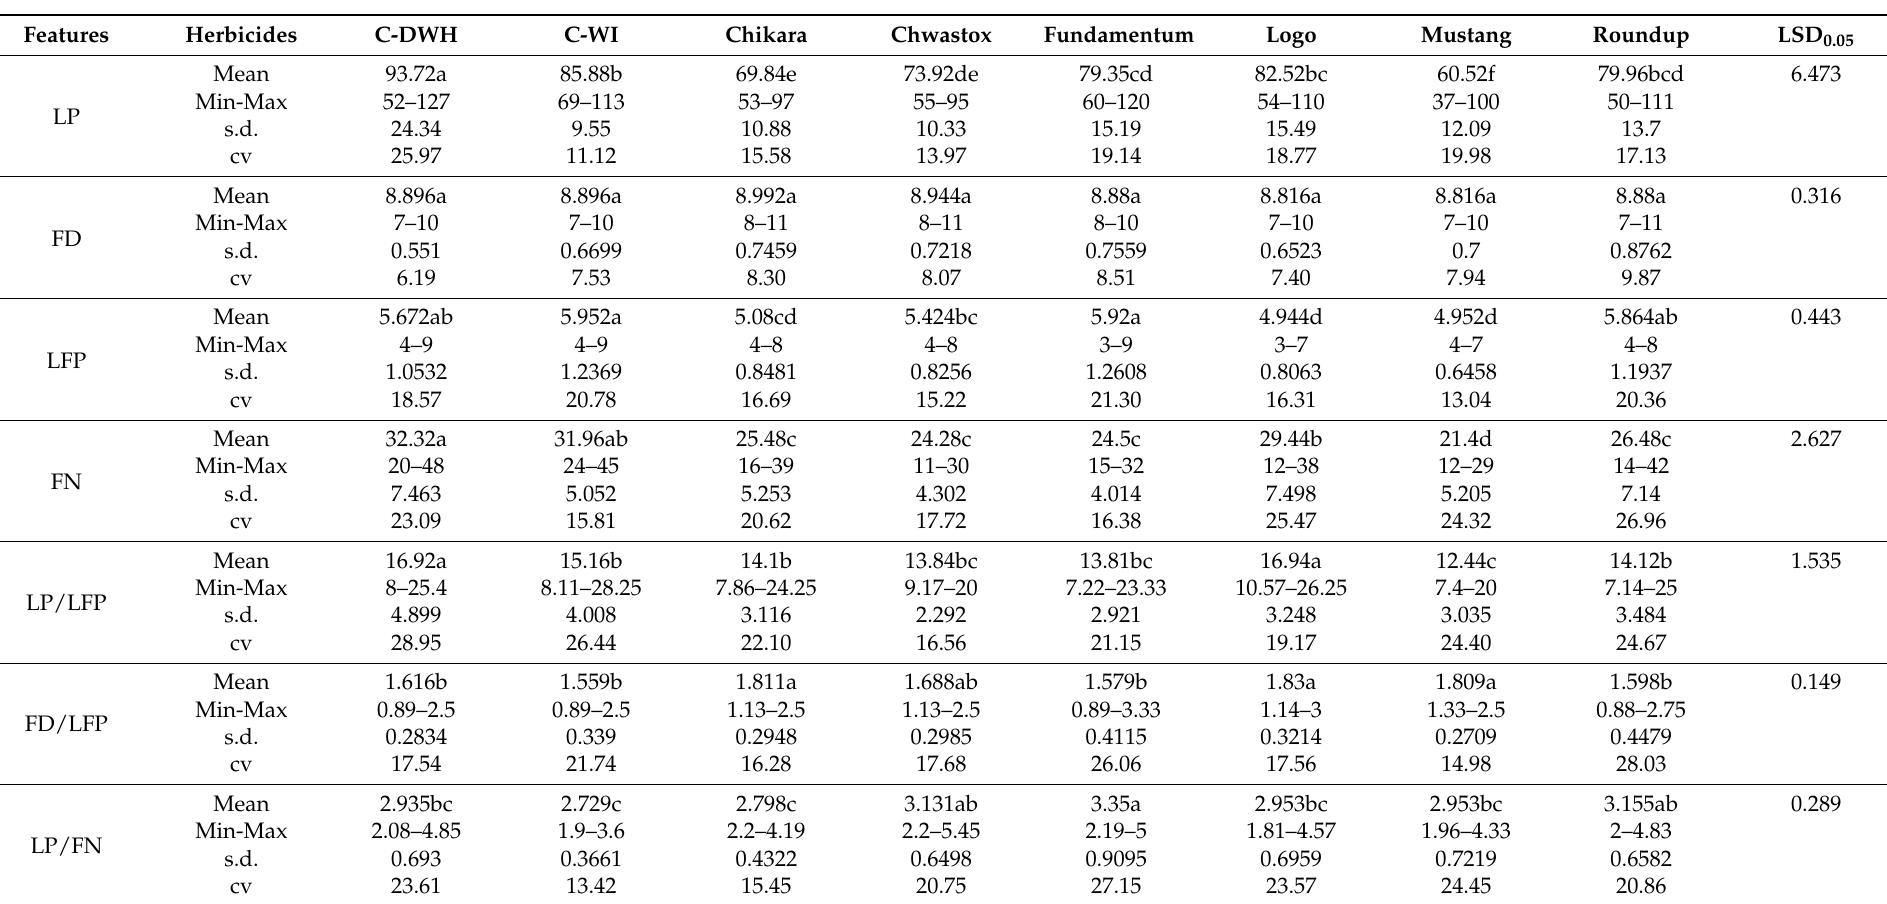
Table 2. The minimal and maximal values, arithmetical means, standard deviations (s.d.) and coefficients of variation (CVs) of observed features for particular